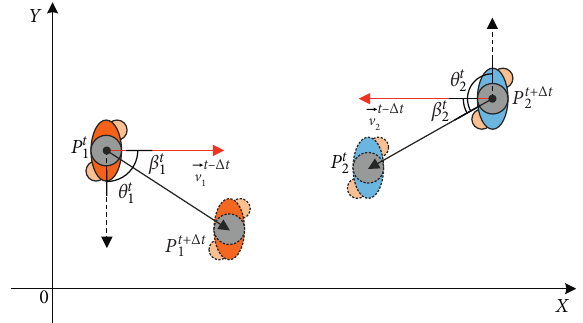
Figure 4: Schematic diagram of the velocity direction angle of the pedestrian at the time step t − Δ t . θ t − Δ t i represents the angle between the vector of (0, − 1) and the pedestrian direction vector v